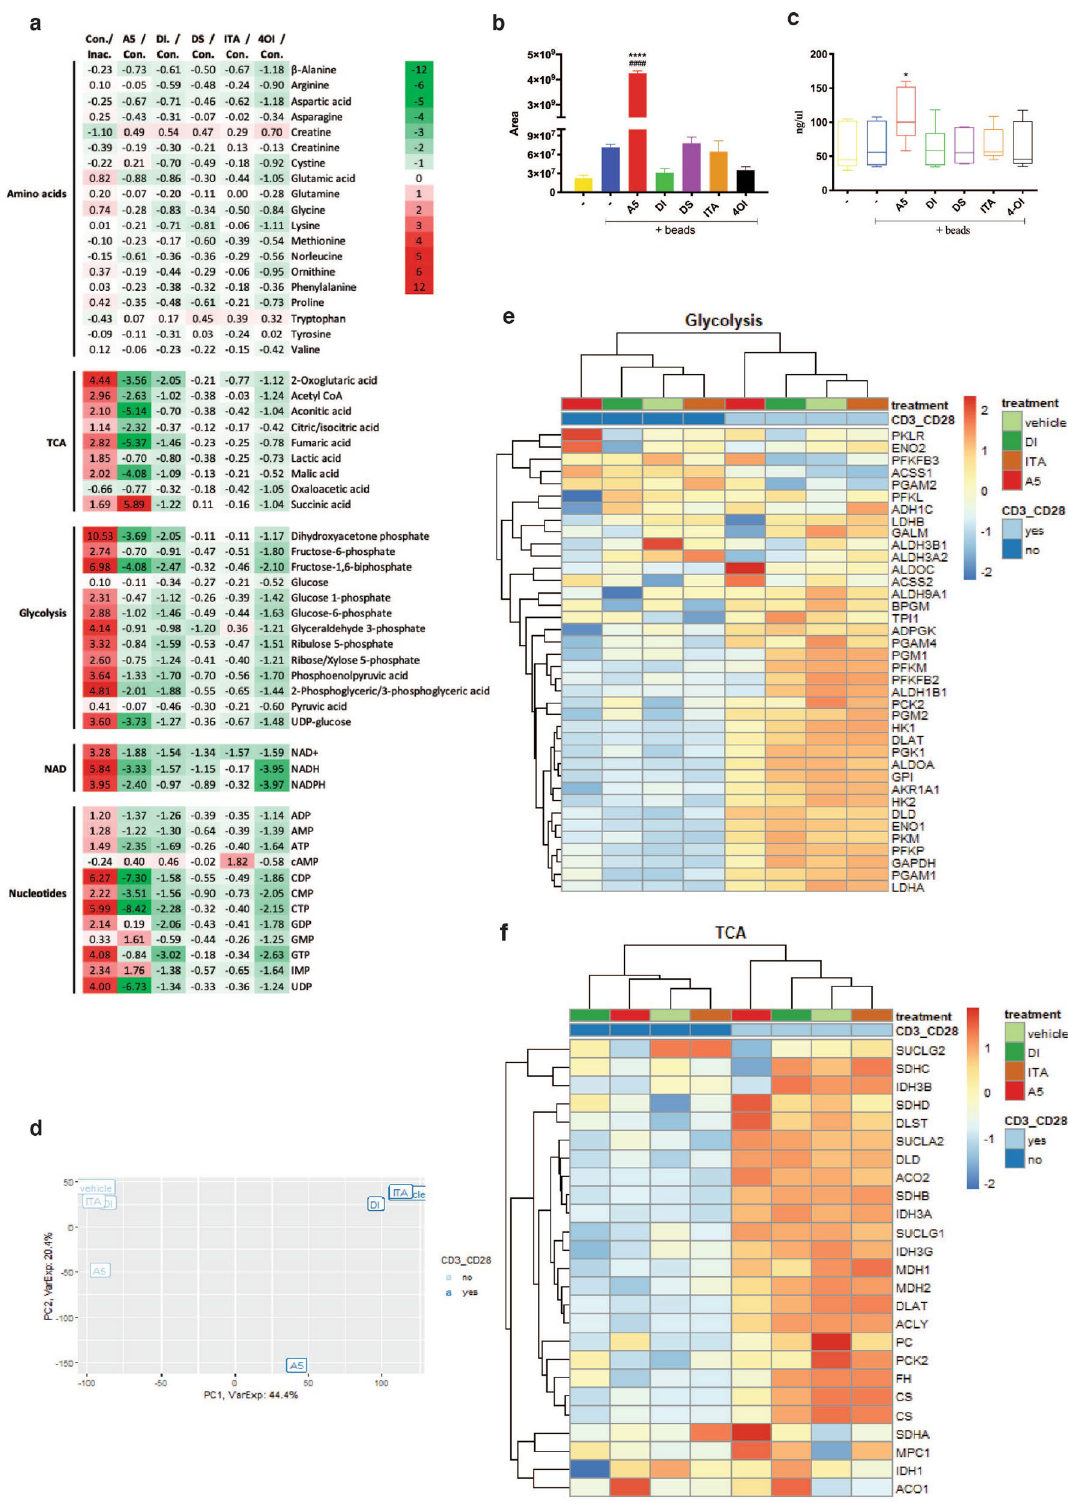
Figure 2. Role of TCA in human CD4 + T cells. Activated CD4 + T cells treated with A5 (20 μM), DI (250 μM), DS (1 mM), ITA (1 mM), or 4OI (125 μM). ( a ) Cellular metabolites measured by liquid-chromatography–mass spectrometry and shown as heat-map. Fold change values were obtained using the activated untreated cells as control (n = 3 independent experiments). ( b ) Succinic acid measured by LC–MS (n = 3 independent experiments) and ( c ) by Succinate Assay kit (Abcam) (n = 6, with n = 2 technical replicates each). ( d ) Visualization of the samples by principal component analysis plot (PCA) of resting and activated CD4 + T cells. ( e , f ) Heat maps with Z-score of TCA- and glycolysis- related genes from Affimetrix gene expression array performed on (pooled RNA from n = 3 experiments) resting and beads-activated CD4 + T cells exposed to A5, DI, or ITA. The bar blots are representative of mean and ± s.e.m ( b ) and boxes are representative of mean and 5–95 percentile. P values are calculated using one-way ANOVA test followed by Dunnet’s test to different control groups: (#) to the unstimulated and untreated control, and (*) to the activated untreated control. # or *P < 0.05, ## or **P < 0.01, ### or ***P < 0.001, #### or ****P <